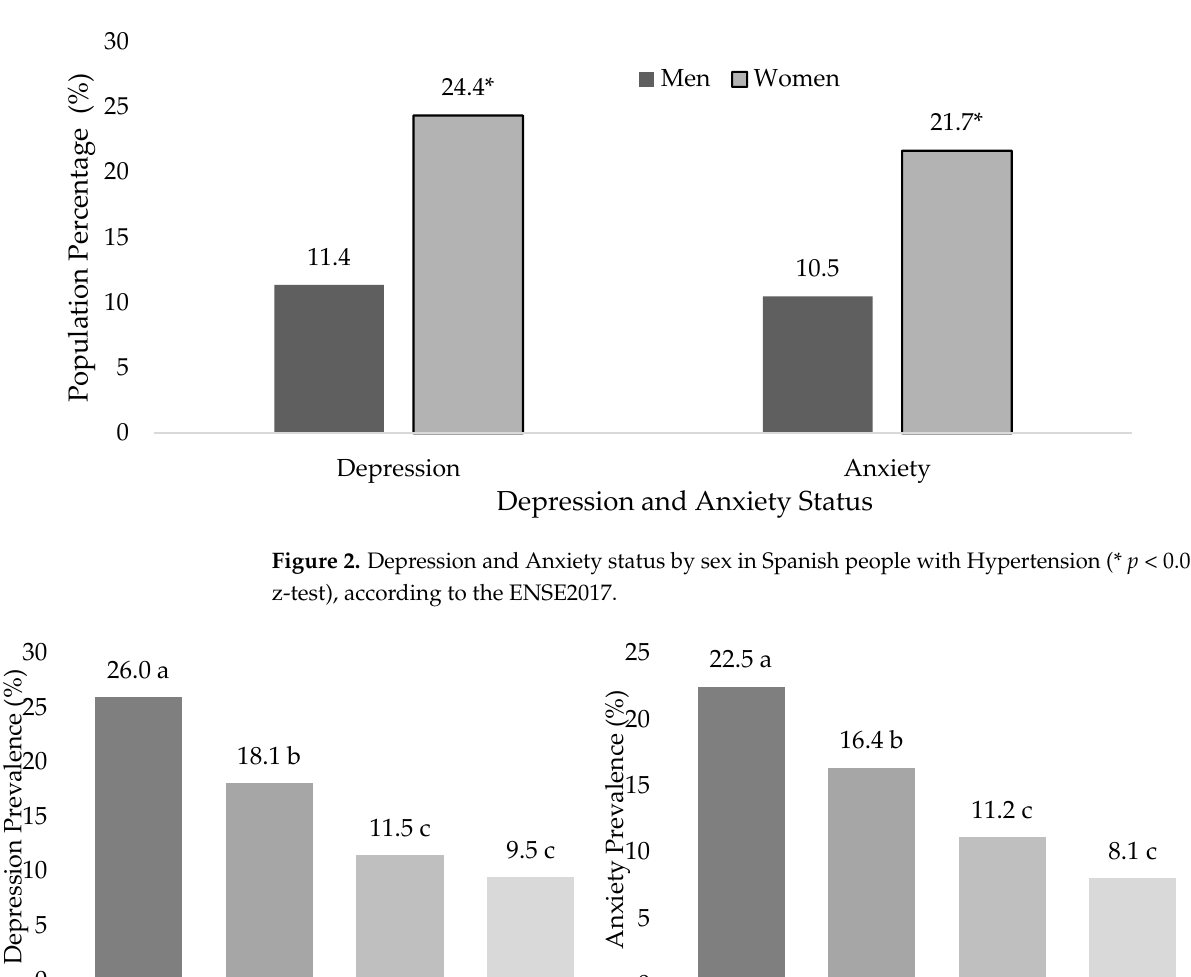
Figure 3. Depression and Anxiety status according to the Physical Activity Level in Spanish people with Hypertension (ENSE2017). abc (Different letters mean significant differences between Physical Activity group ratios. p < 0.05 from z-test).